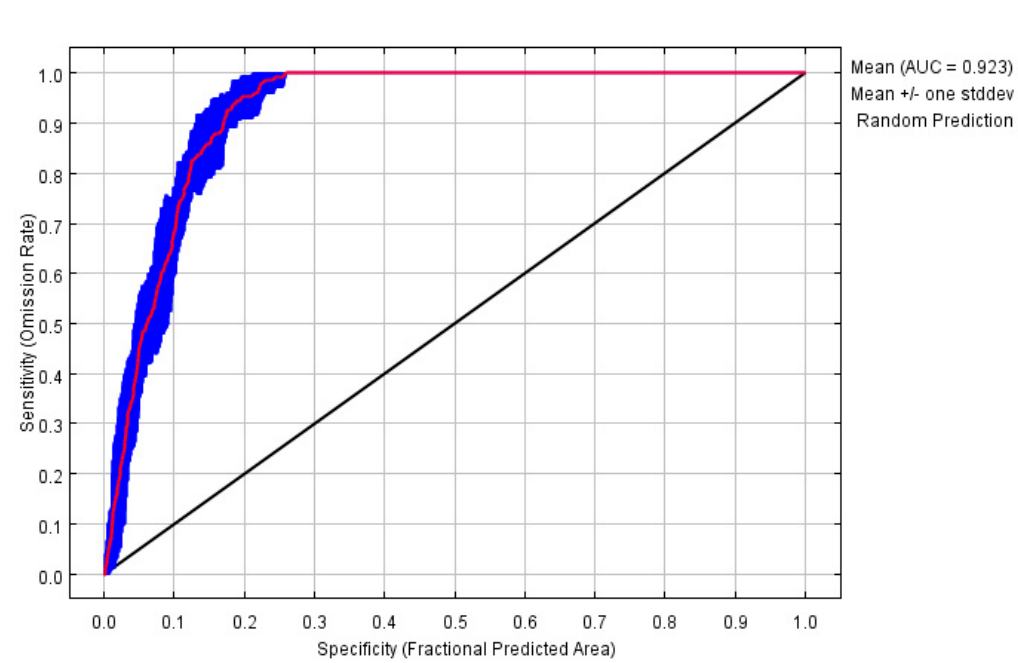
Figure A2. This picture shows the results of the jackknife test of variable importance in the camphor tree habitat distribution model. The environmental variable with highest gain when used in isolation is MAT, which therefore appears to have the most useful information by itself. Values shown are averages over replicate runs. References 1.